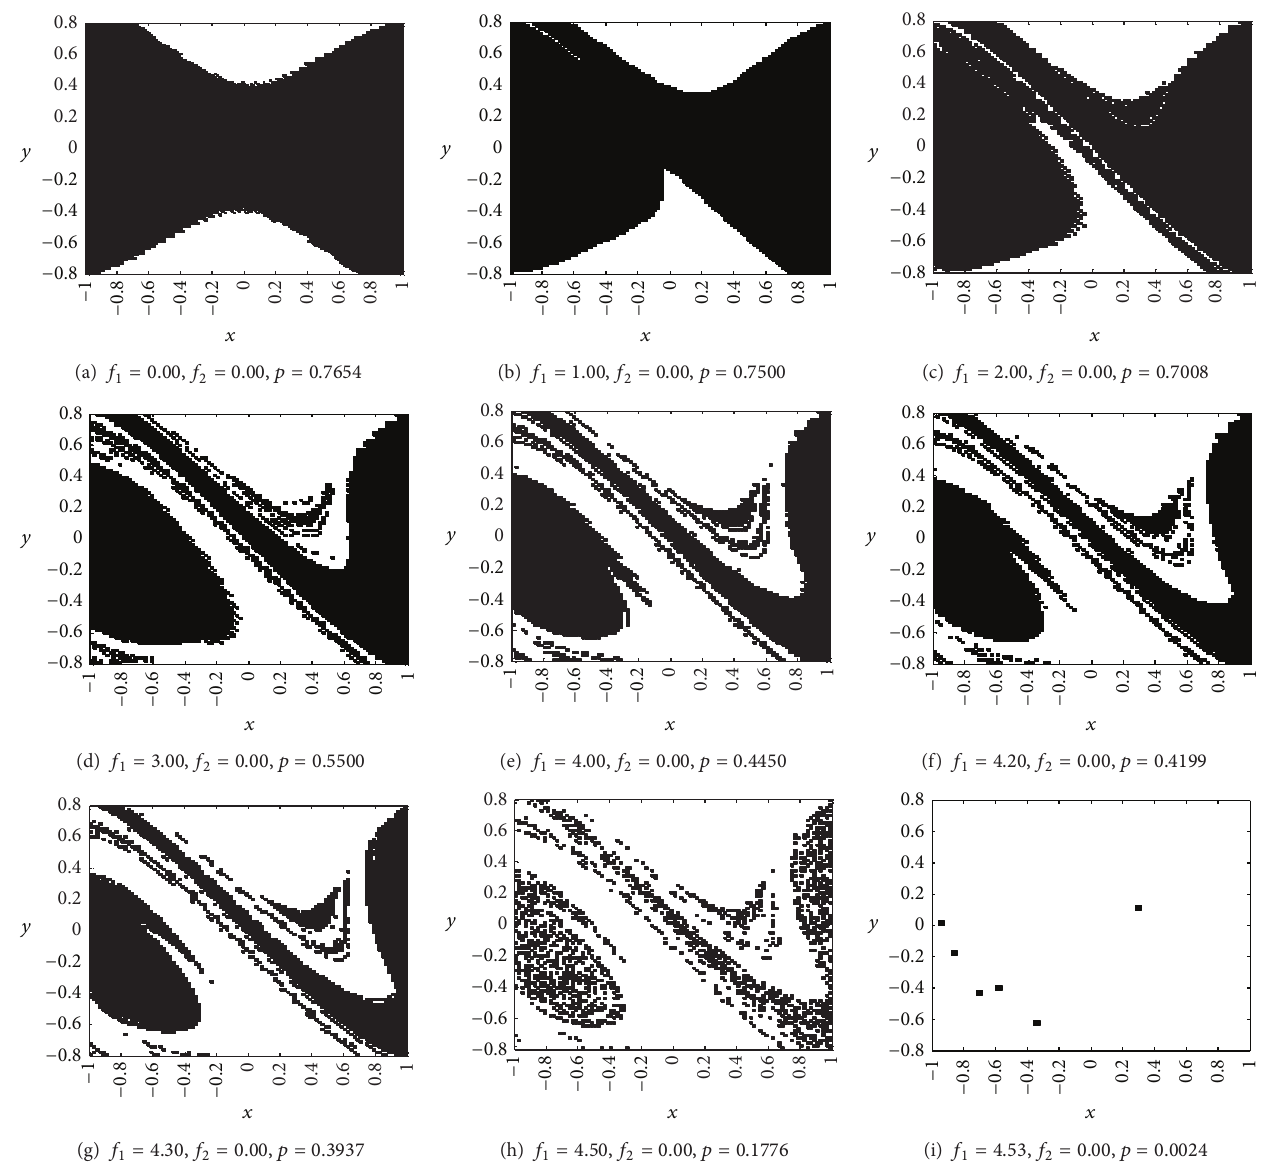
Figure 7: Erosion of safe basins in system (1): ( 𝑓 2 = 0